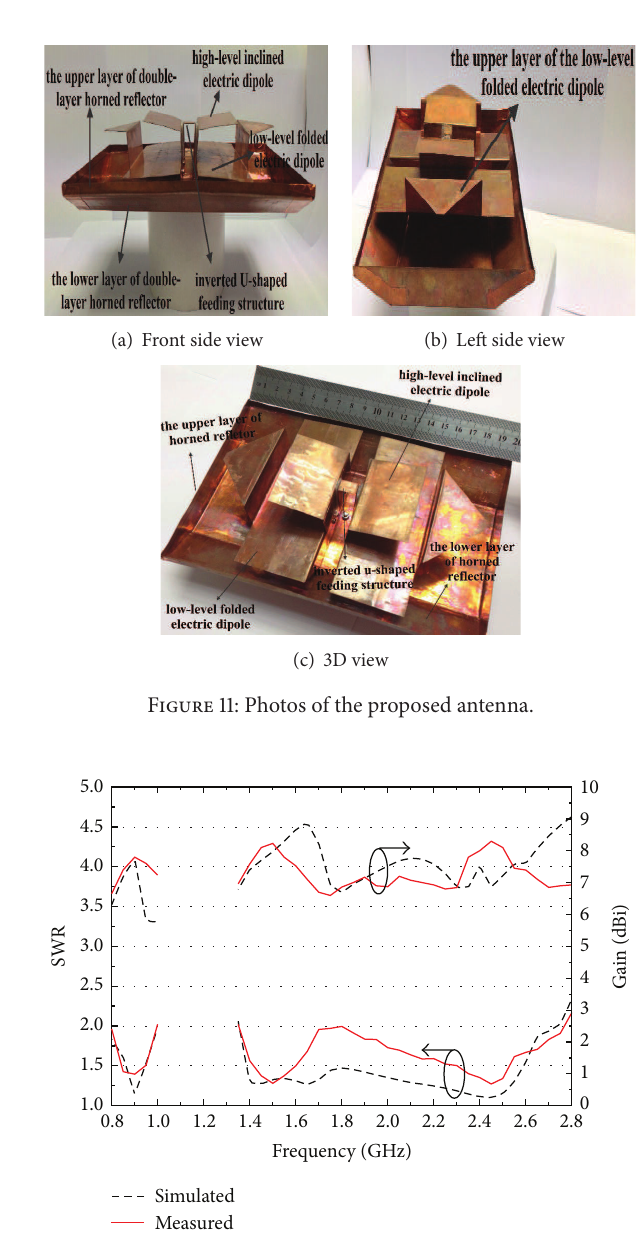
Figure 12: Simulated and measured SWRs and broadside